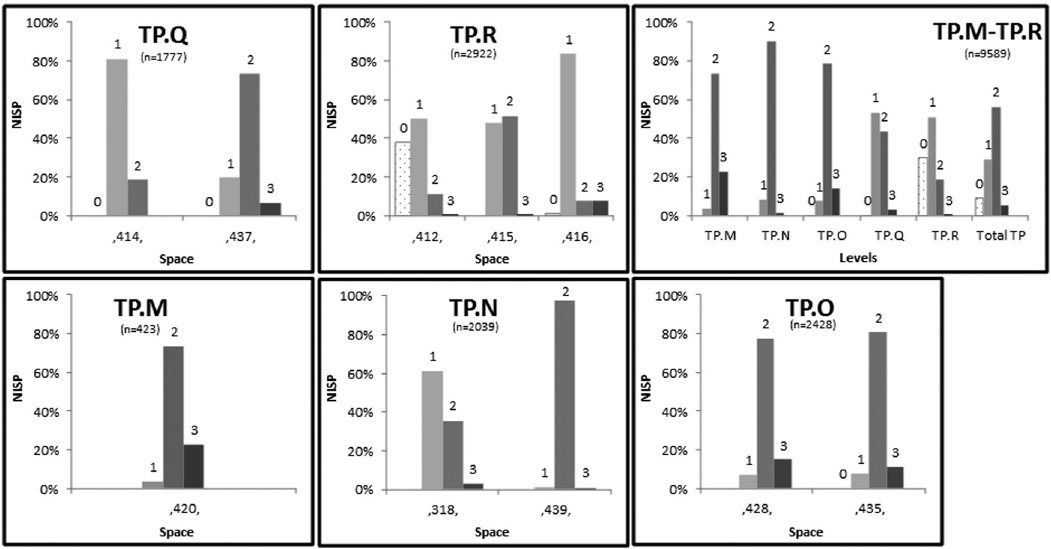
Figure 7: Çatalhöyük East, TP middens. Weathering pro fi le of animal bones within the spaces in each level in the TP sequence. Abbreviations: 0 – 3 weathering stages; 0: unweathered; 1: very slightly weathered; 2: slightly weathered; and 3: moderately